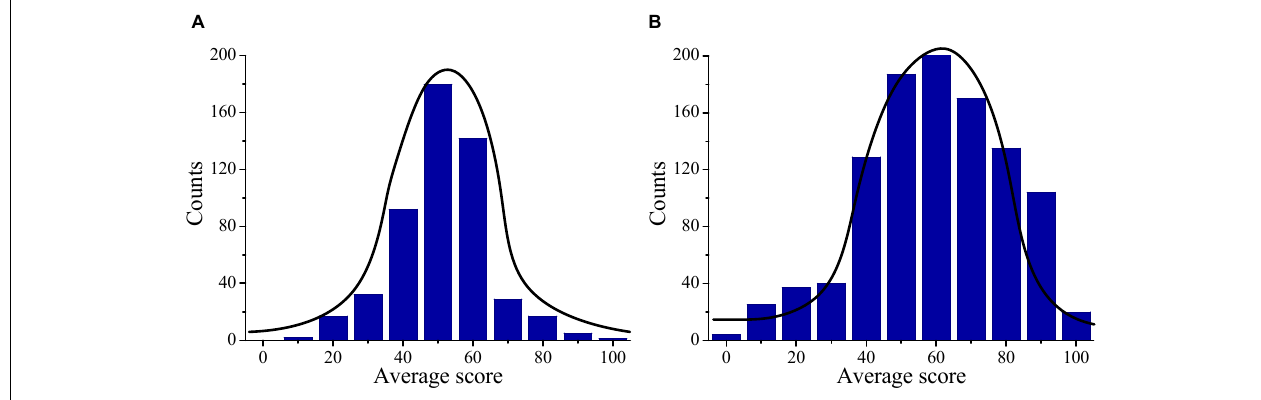
FIGURE 10 | Descriptive statistics on final examination scores of children. (A) Illustrates the score distribution of migrant children; and (B) illustrates the score distribution of local children.